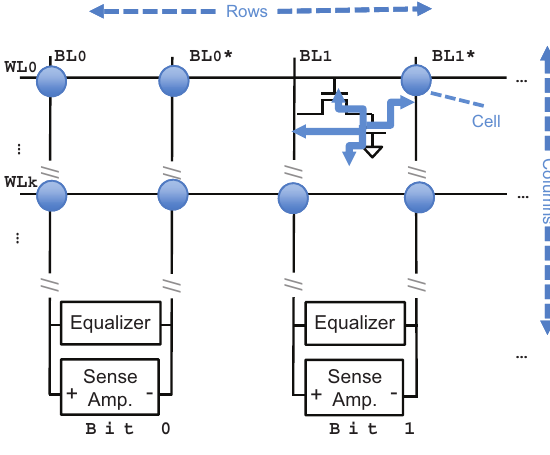
Figure 3. The architecture of